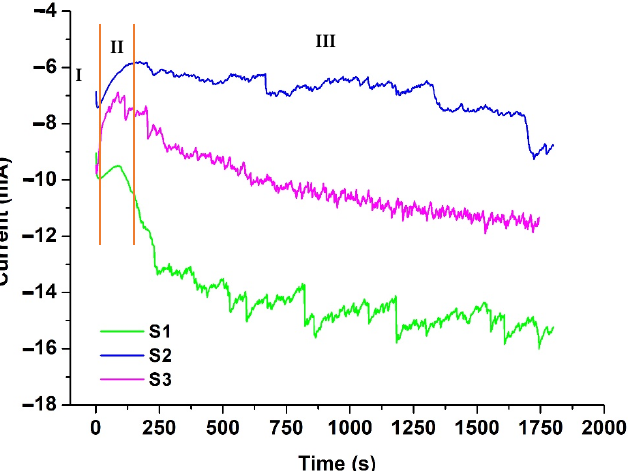
Figure 2. Experimental current density transients recorded during the electrodeposition onto the titanium substrate from the system ChCl/EG with Fe and Mn salt addition at 80 °C.